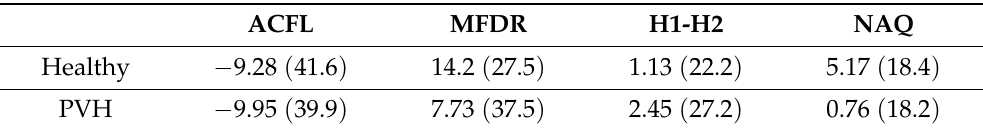
Table 4. Median (interquartile range) of RMSE ∆ s in percentage (%) of the modified Kalman filter with respect to the standard